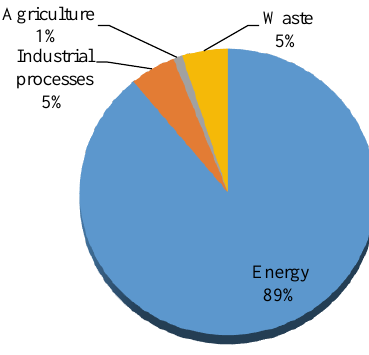
Figure 1. Carbon dioxide emission for Saudi Arabia: The year 1970–2016 [2].